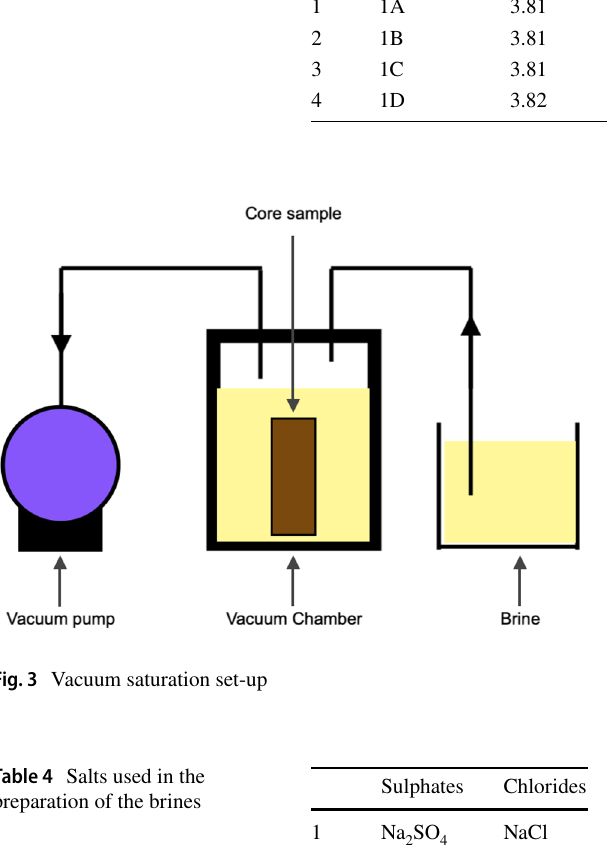
Table 3 Dimension and petrophysical properties of core samples